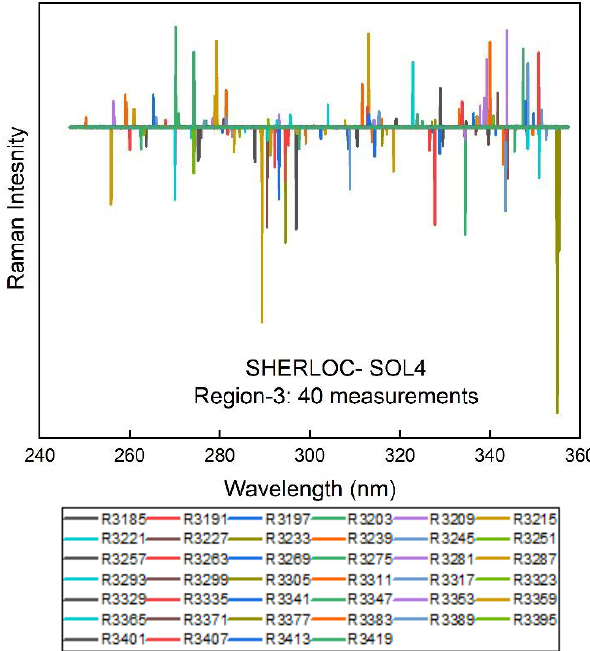
Figure 9. Full range PC1vs. PC2 (Region-2)